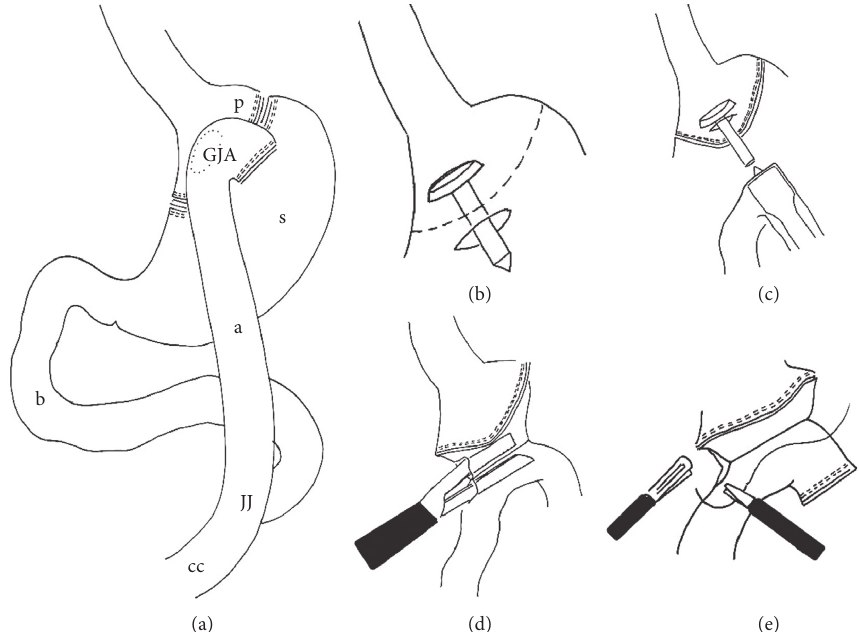
Figure 1: Circular and linear stapler techniques for gastrojejunal anastomosis. (a) Roux-en-Y gastric bypass. CSA technique: (b) inserting the stapler head in the stomach before gastric pouch formation; (c) forming the gastric pouch and leading out the central rod from the pouch, inserting the circular stapler into the jejunal loop, and performing anastomosis. LSA technique: (d) after forming the stomach pouch, the jejunal loop is brought near and fixed with a holding thread, opening of the stomach pouch and the jejunal loop and introduction of the linear stacker, and preparation of the anastomosis; (e) closure of the opening for the stacker. GJA: gastrojejunal anastomosis, p: stomach pouch, s: residual stomach, b: biliary limb, a: alimentary limb, jj: jejunojejunostomy, and cc: common channel (the anastomosis was shown here once in front of and once behind the stapler suture row of the stomach pouch for simpler